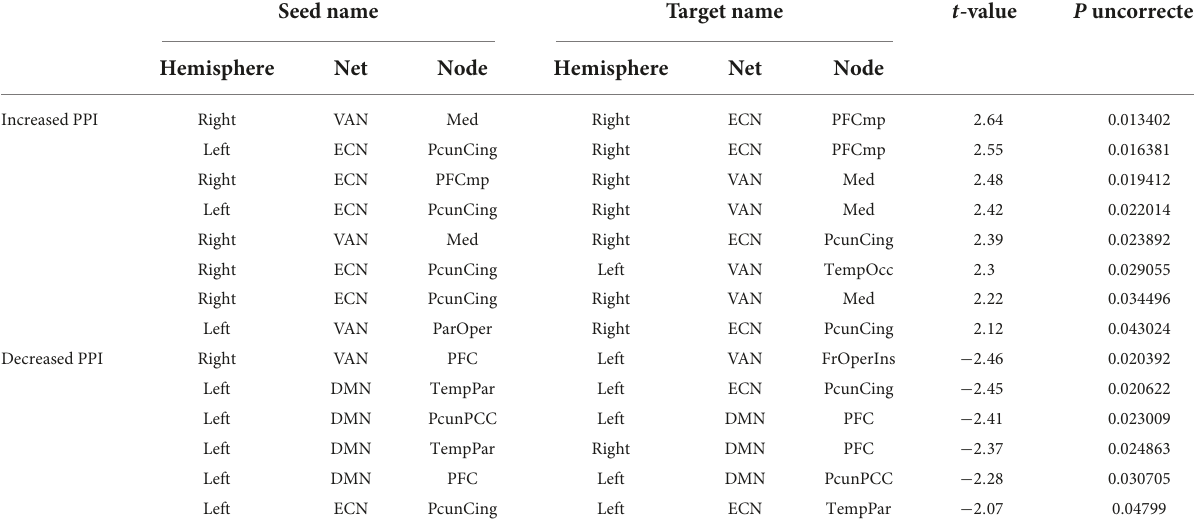
TABLE 3 ROI-to-ROI time by intervention interaction in PPI connectivity: Exploratory results.